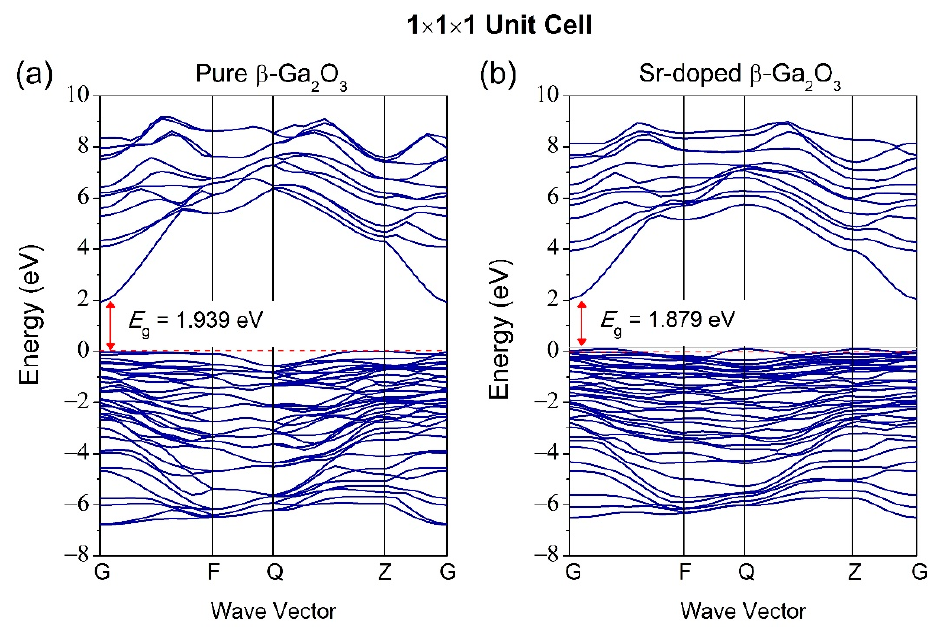
Figure 5. Band structure of ( a ) pure β -Ga 2 O 3 and ( b ) Sr-doped β -Ga 2 O 3 without scissor operator.